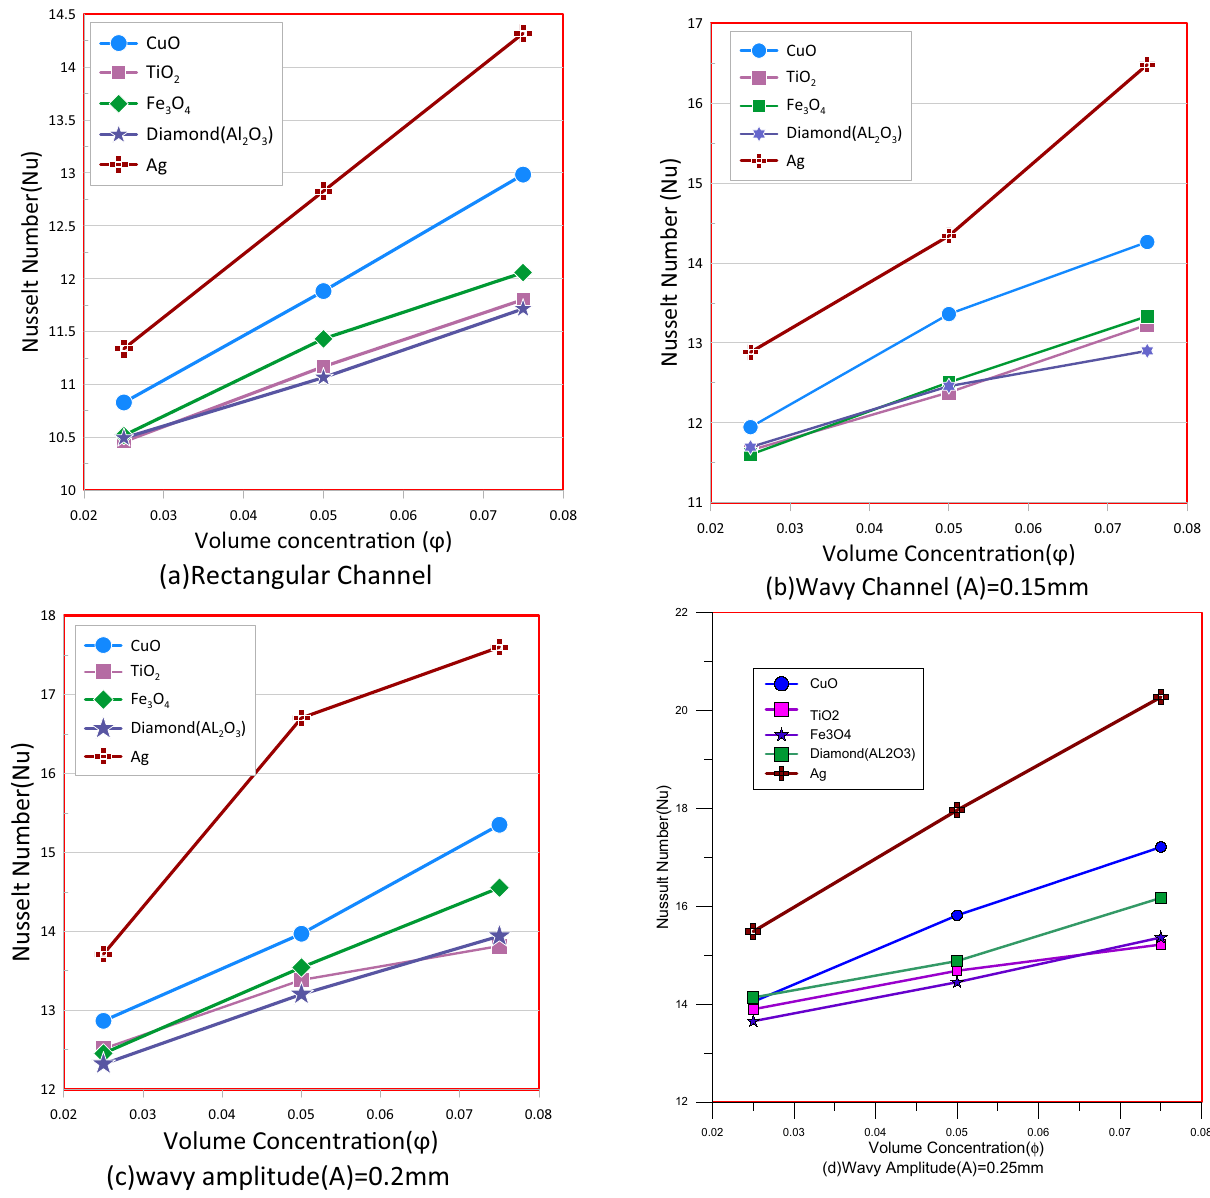
(d)Wavy Amplitude(A)=0.25mm